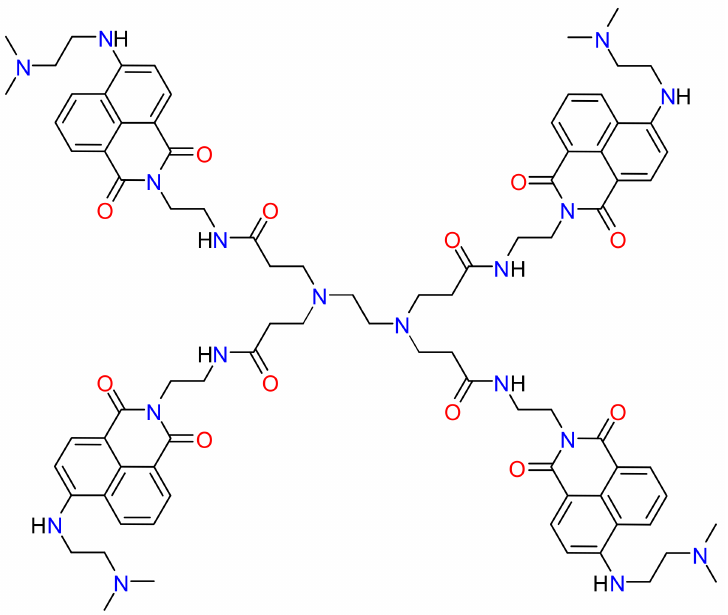
Figure 1. Chemical structure of the synthesized fluorescent dendrimer (FCD)